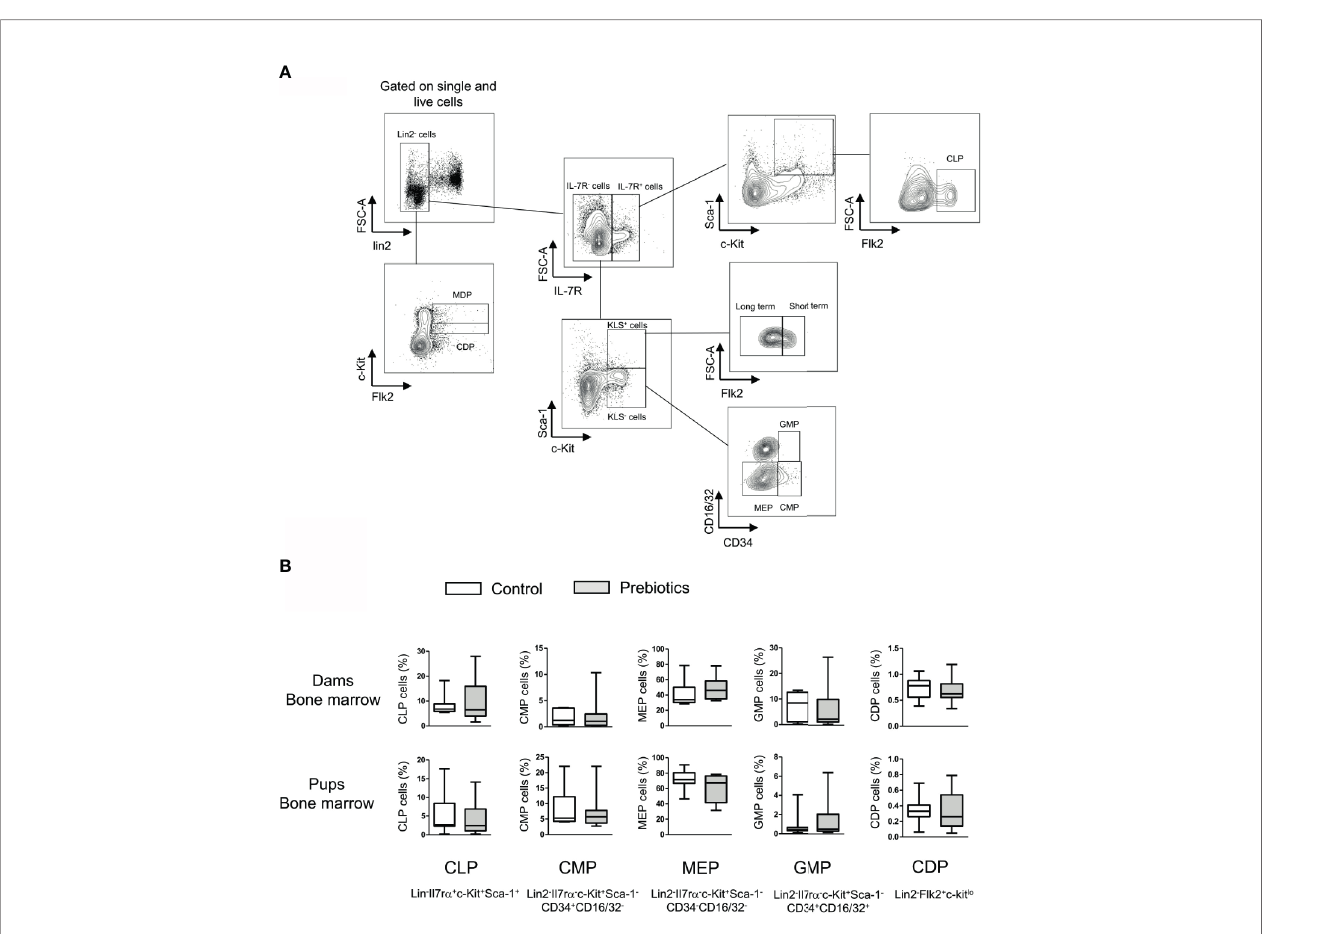
FIGURE 4 | Effects of GOS/inulin supplementation during pregnancy on hematopoietic stem and progenitor cell frequency in bone marrow from dams and fetuses. (A) Gating strategy used after immunostaining to evaluate all HSC and progenitor cell subsets. (B) Assessment of common lymphoid progenitor (CLP), common myeloid progenitor (CMP), megakaryocyte-erythrocyte progenitor (MEP), granulocyte-macrophage progenitor (GMP) and common DC precursor (DCP) frequencies in the bone marrow of dams and pups fed a control diet (white) or supplemented with GOS/inulin (gray)